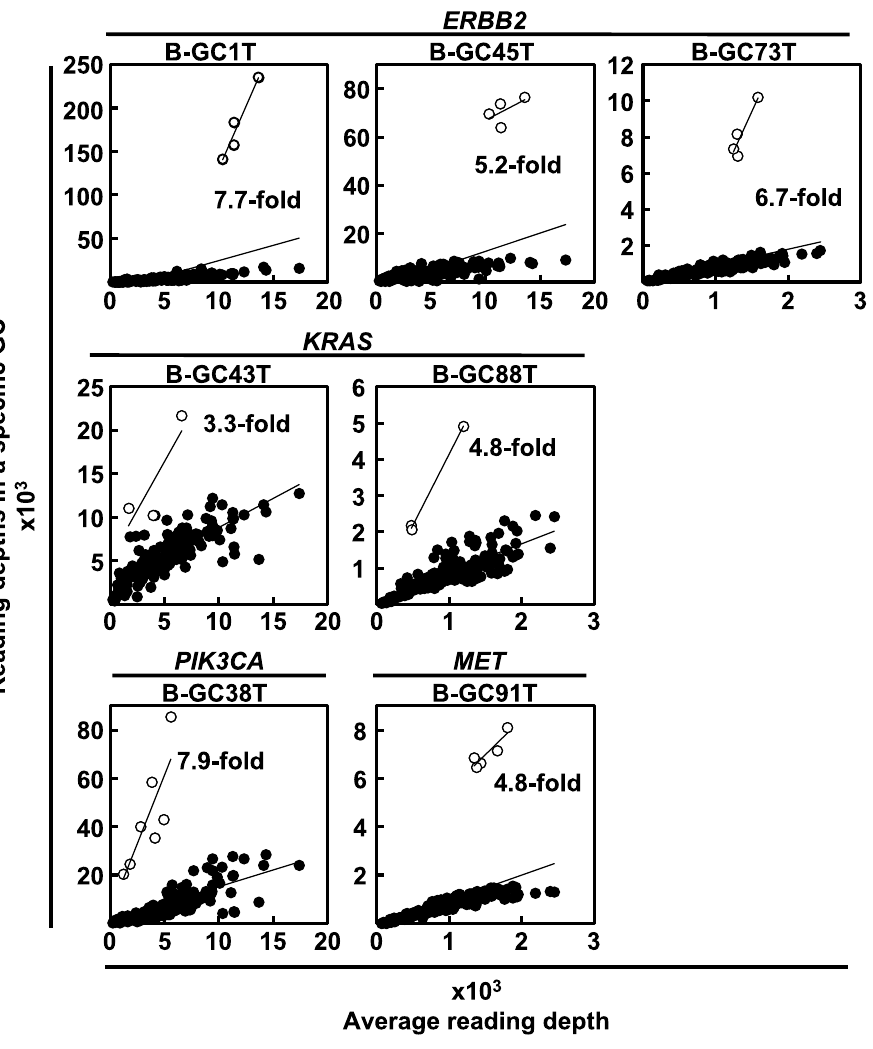
Figure 2. Gene amplification analysis of cancer-related genes. Gene amplification of 26 cancer-related genes was evaluated by utilizing reading depth of individual genes. For an individual sample, reading depths of 160 amplicons were plotted in a panel. Each amplicon was expected to be on a regression line calculated from all amplicons, but amplicons of the amplified gene were outlying. ERBB2 was amplified in 3 gastric cancers; KRAS was amplified in 2 cancers; and PIK3CA and MET were amplified in one cancer. Open circles show the amplicon of amplified genes. Black circles show that of all the other